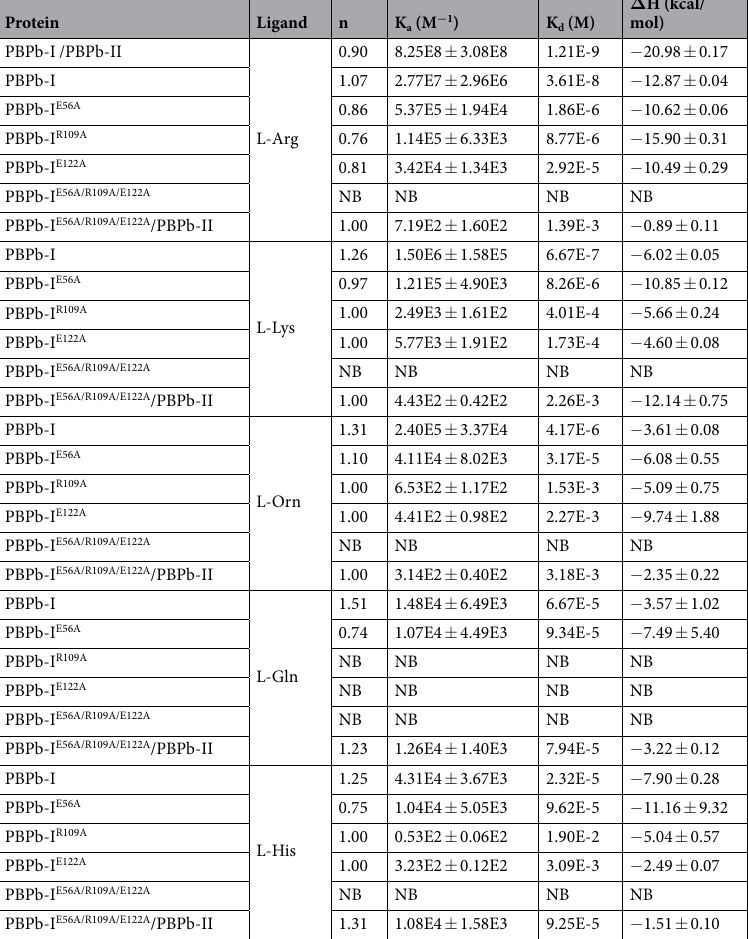
Table 2. ITC analysis of interactions between different amino acids and the periplasmic portion of CdgH with different truncations and mutants. NB: no detactable